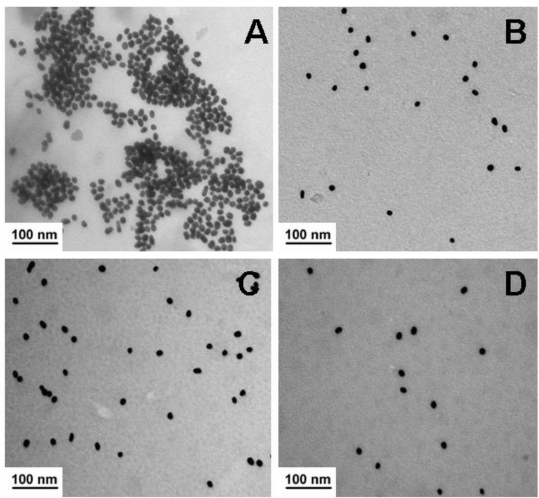
Figure 4. TEM images of gold nanoparticles protected by sodium citrate under pH = 7.0 ( A ) and PNIPAM- b -PLL chains under pH = 2.0 ( B ), pH = 7.4 ( C ) and pH = 12.0 ( D ).